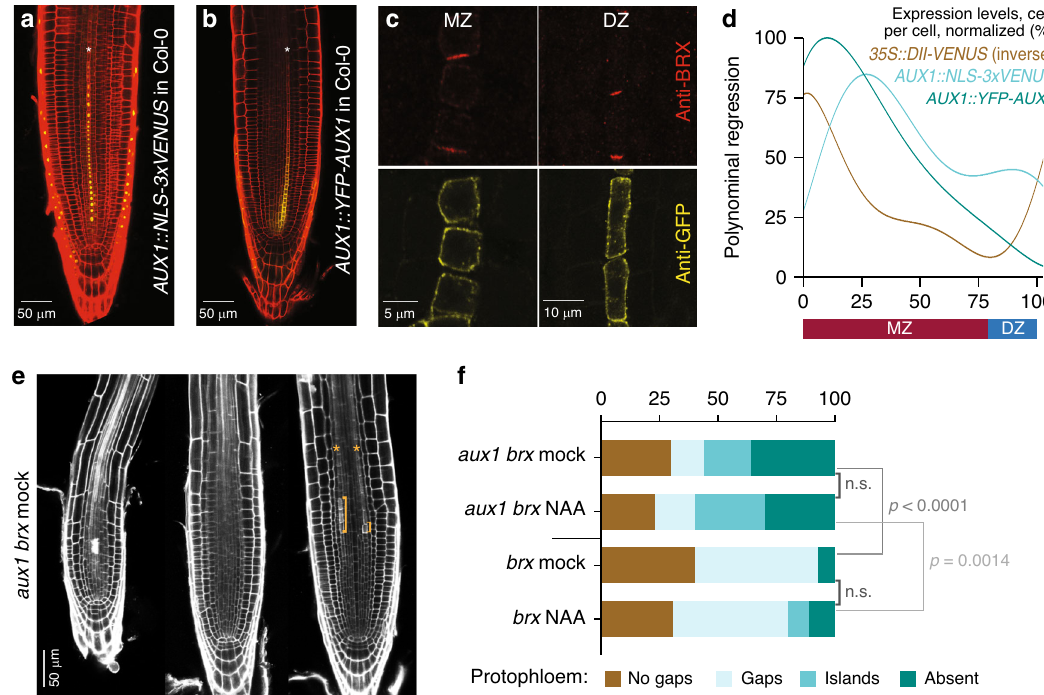
Fig. 2 Intermittent gap cell patterning depends on the auxin in fl ux facilitator AUX1. a , b Confocal imaging (PI staining, red) of AUX1 transcriptional ( a ) and translational ( b ) reporter genes (yellow). c Anti-GFP immunostaining of YFP – AUX1 fusion protein (yellow) in developing PPSEs, with simultaneous anti-BRX staining (red) for PPSE identi fi cation. d Relative expression levels of AUX1 reporters and the inverse auxin sensor DII-VENUS along developing PPSE cell fi les, fi tted from experimental data (see Supplementary Fig. 3). e Phenotypic range of aux1 brx double-mutant root meristems, including isolated “ islands ” of differentiation (brackets). f Quanti fi cation of phenotype classes in aux1 brx double and brx single mutants, in mock conditions or upon treatment with 50 nM of the membrane-soluble synthetic auxin 1-naphthylacetic acid (NAA). Statistical signi fi cance of differences (chi-square test) are indicated. See Source Data for raw measurements and statistical test